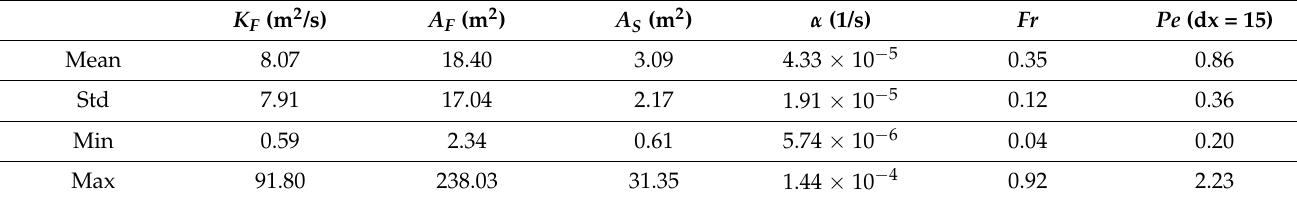
Table 5. Statistics of the estimated TSM parameters of 48 sub reaches and the estimated non-dimensional parameters of the CAS scenarios in Gam